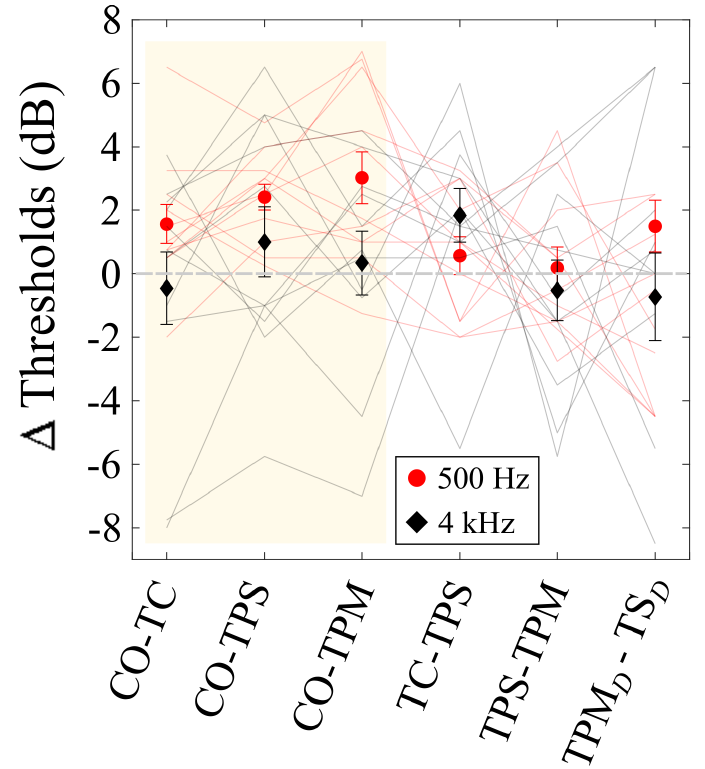
Figure 3. Mean change in tone–in–noise detection thresholds across 11 listeners. Error bars indicate ± 1 standard error of the mean. The first 3 comparisons, indicated by the shaded area, represent measures of Spatial Release from Masking. The remaining data show comparisons of thresholds between other conditions. Individual data are represented with thin lines connecting performance for each condition, and are color coded the same as the mean